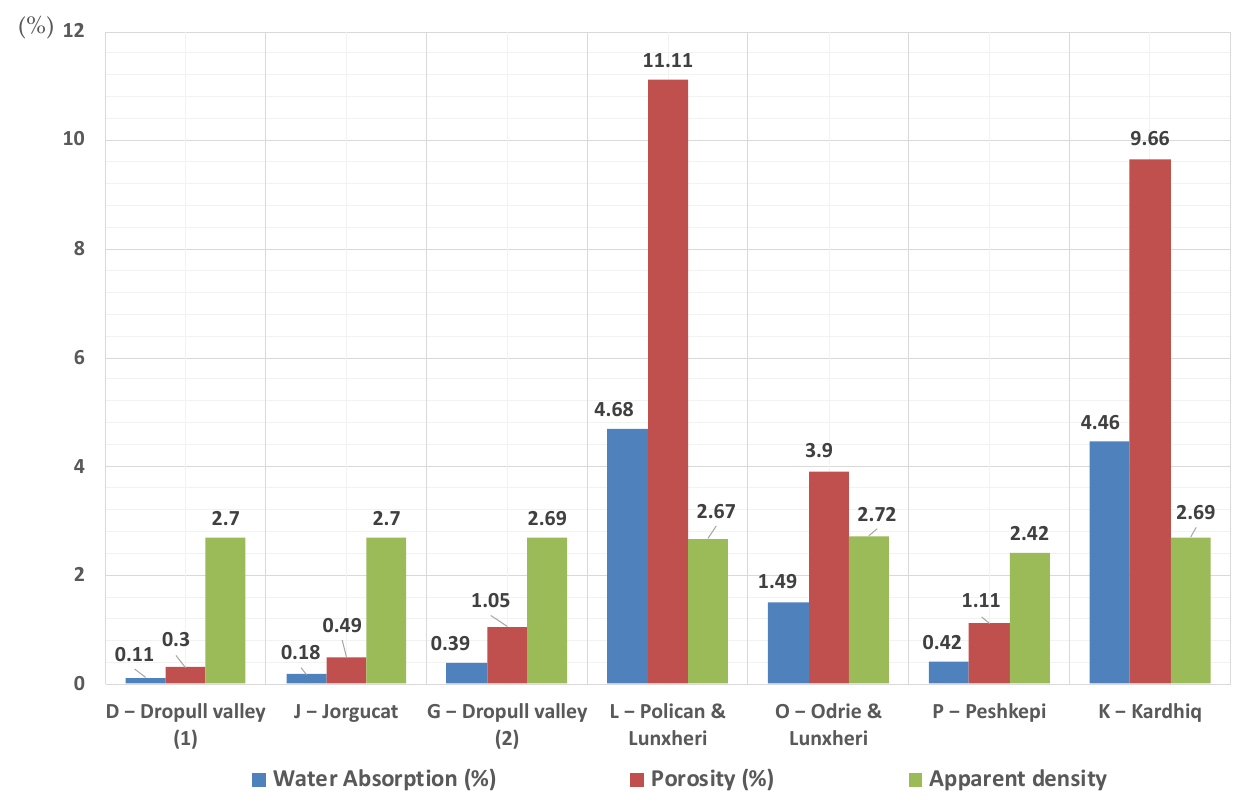
Figure 12. Physical properties of the tested specimens.